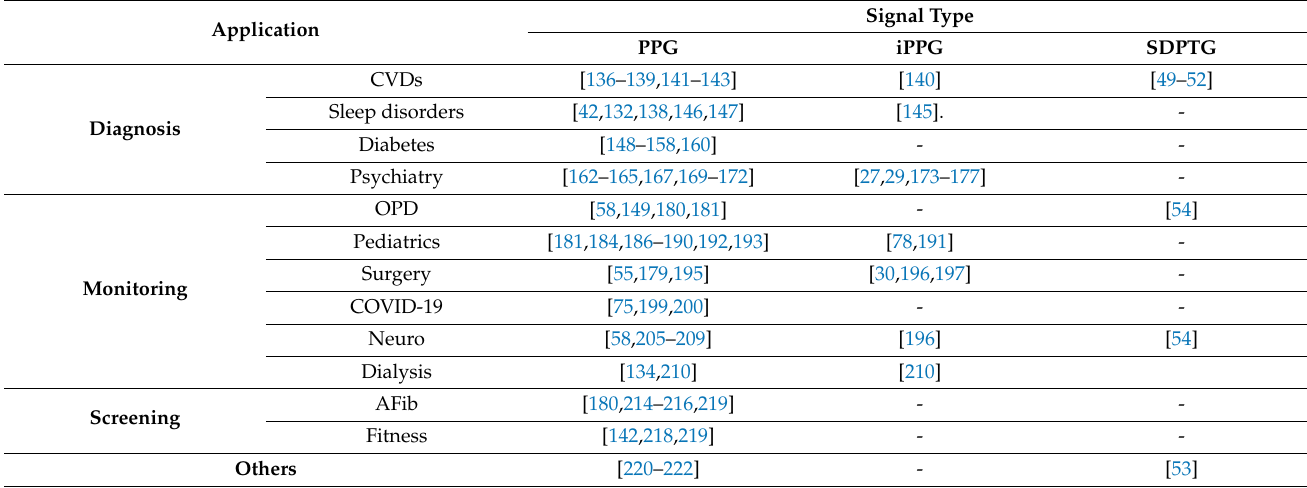
Table 3. Different PPG waveforms and their application based on health domain.